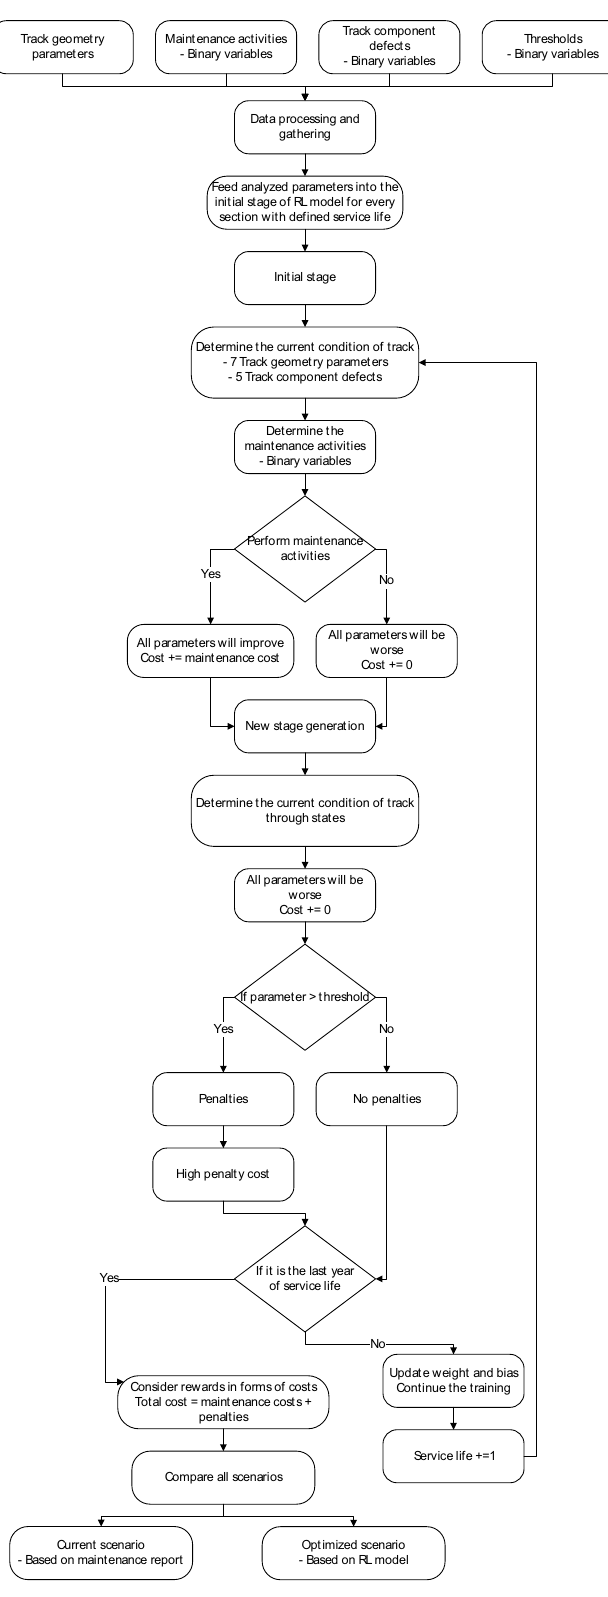
Figure 7. Workflow of the reinforcement learning